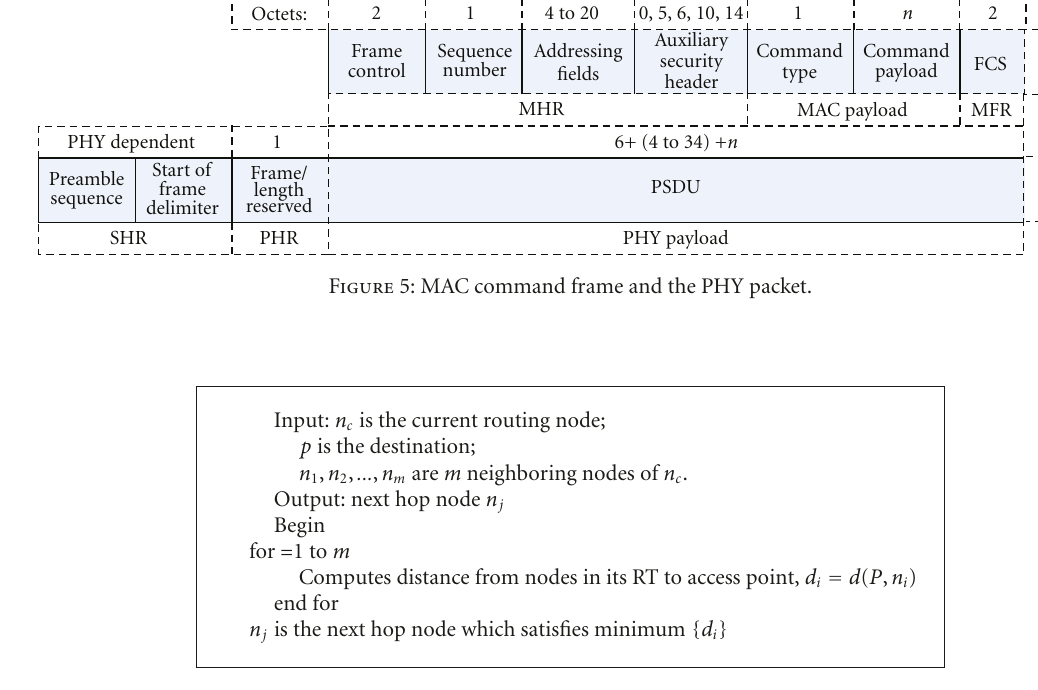
Algorithm 3: Next hop selection scheme within